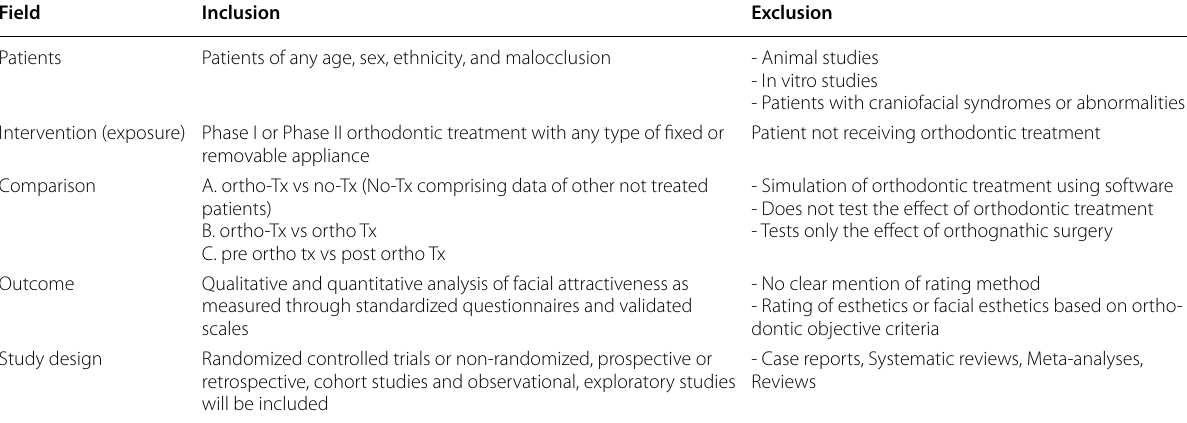
Table 1 Study inclusion and exclusion criteria (PICOS)